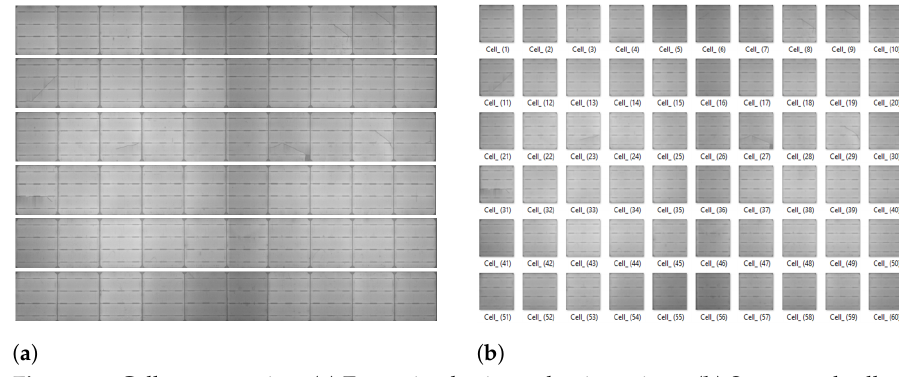
Figure 12. Cell segmentation. ( a ) Extracting horizontal strip regions. ( b ) Segmented cells.